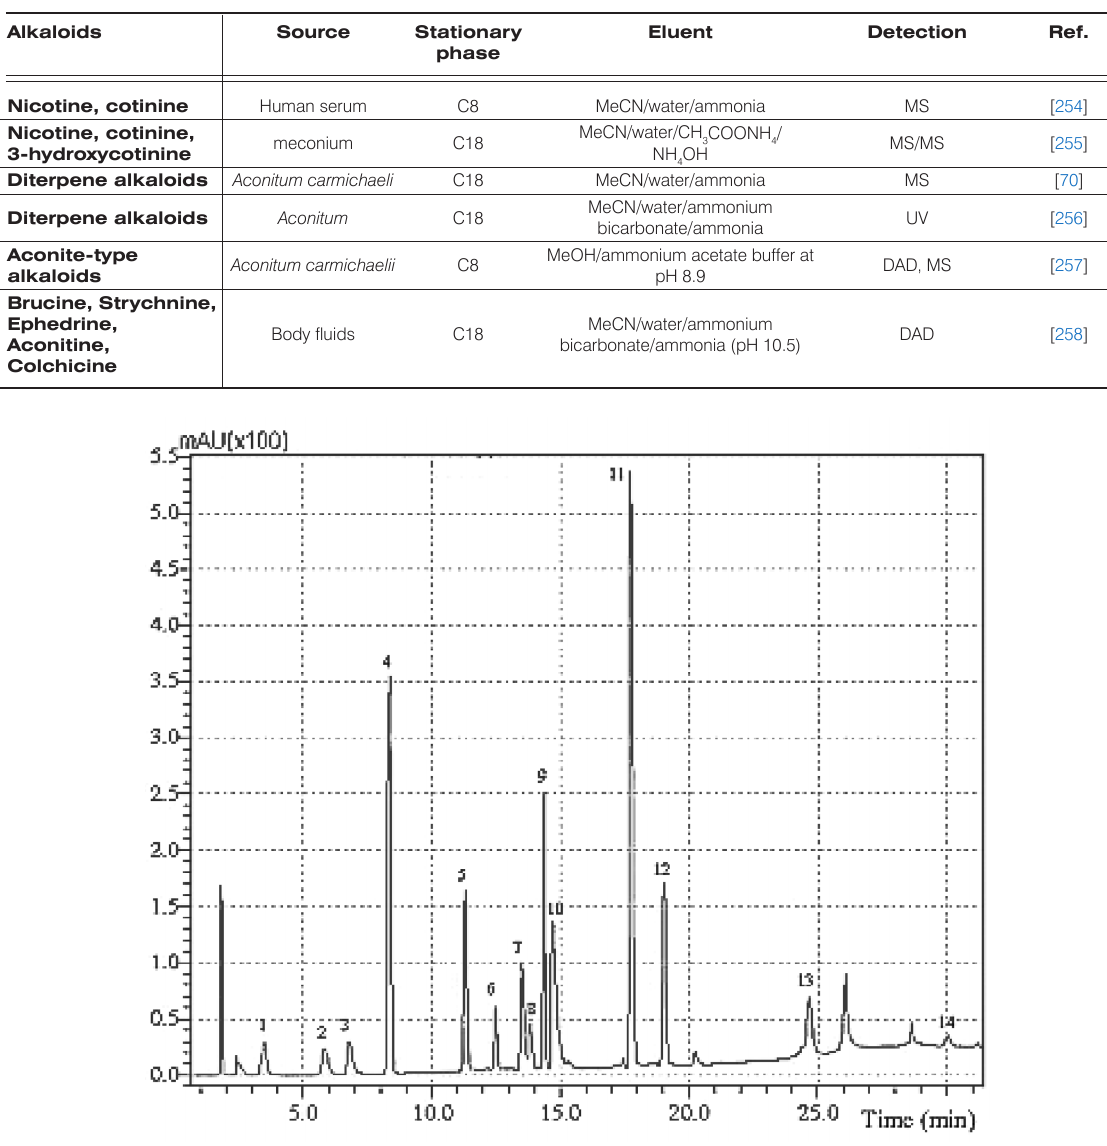
Table 3. Methods used for HPLC of alkaloids with mobile phase at basic pH.